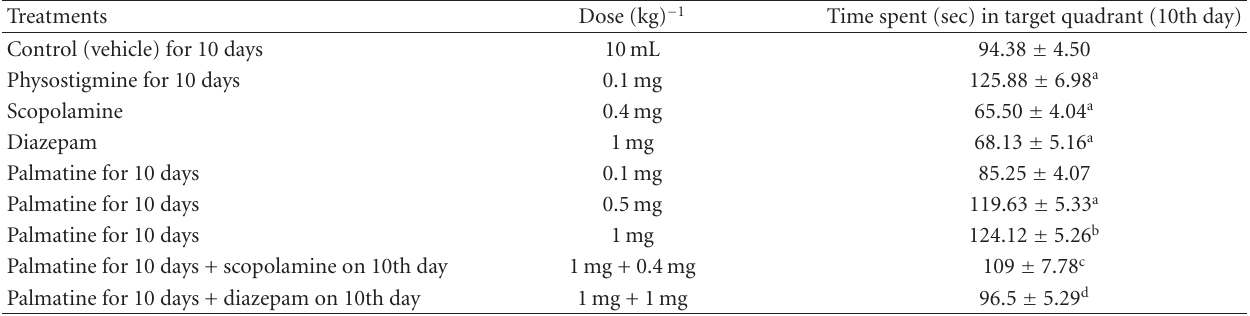
Table 3: E ff ect of palmatine and other drugs employed on time spent in target quadrant of mice using Morris water maze. Treatments